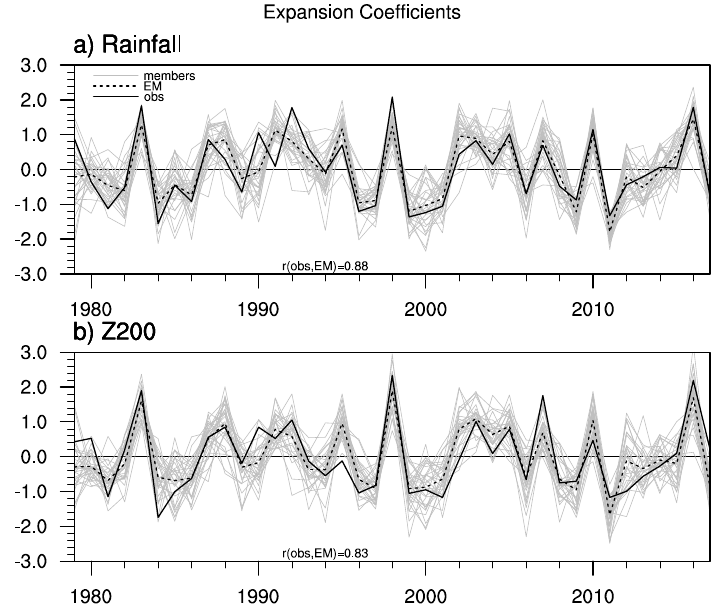
Figure 4. Expansion coefficients of SVDs in Figures 1 and 2 for ( a ) rainfall and ( b ) Z200. Gray lines denote each member, dashed lines denote the ensemble mean, and solid dark lines denote the observation.